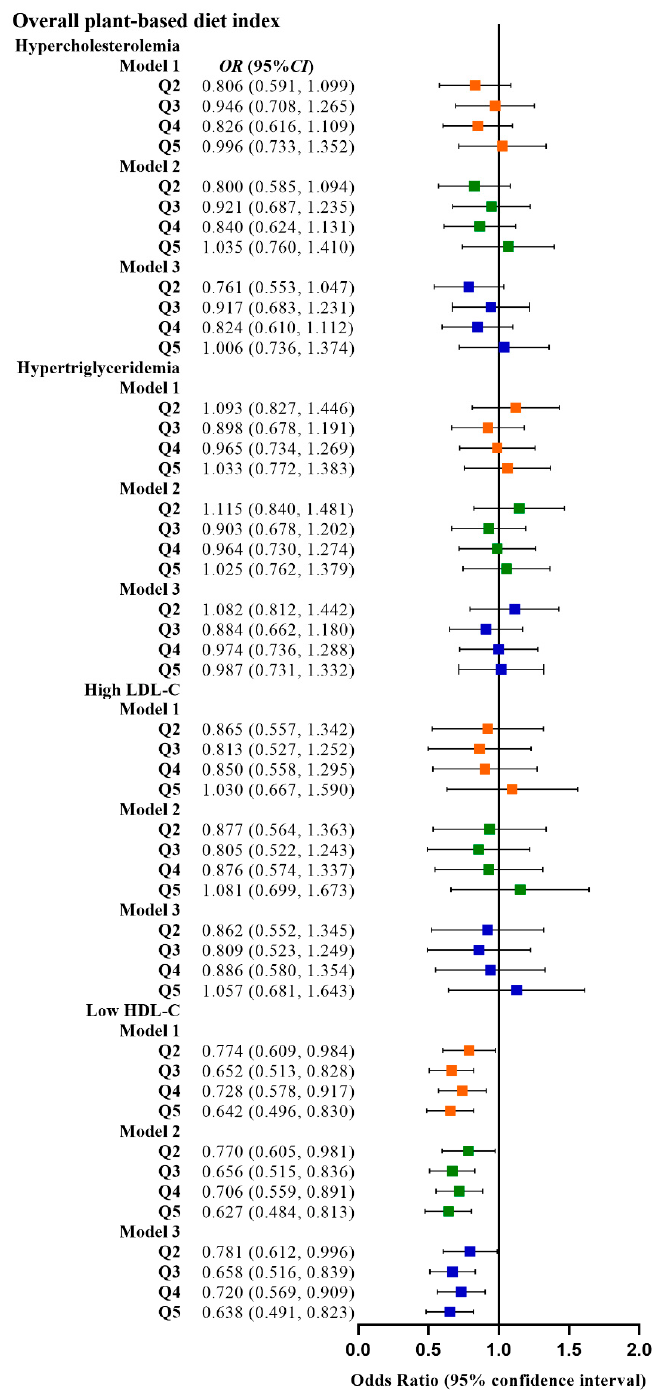
Figure 2. Odds ratios (OR) and 95% confidence intervals (CI) for PDI with different types of dyslipidemia. The squares show odds ratios and the line ranges show 95% confidence intervals. Model 1: unadjusted; model 2: adjusted for sex, age, ethnicity, BMI, socio-economic status, smoking status, alcohol consumption, and physical activity; model 3: additionally adjusted for T2DM and hypertension.